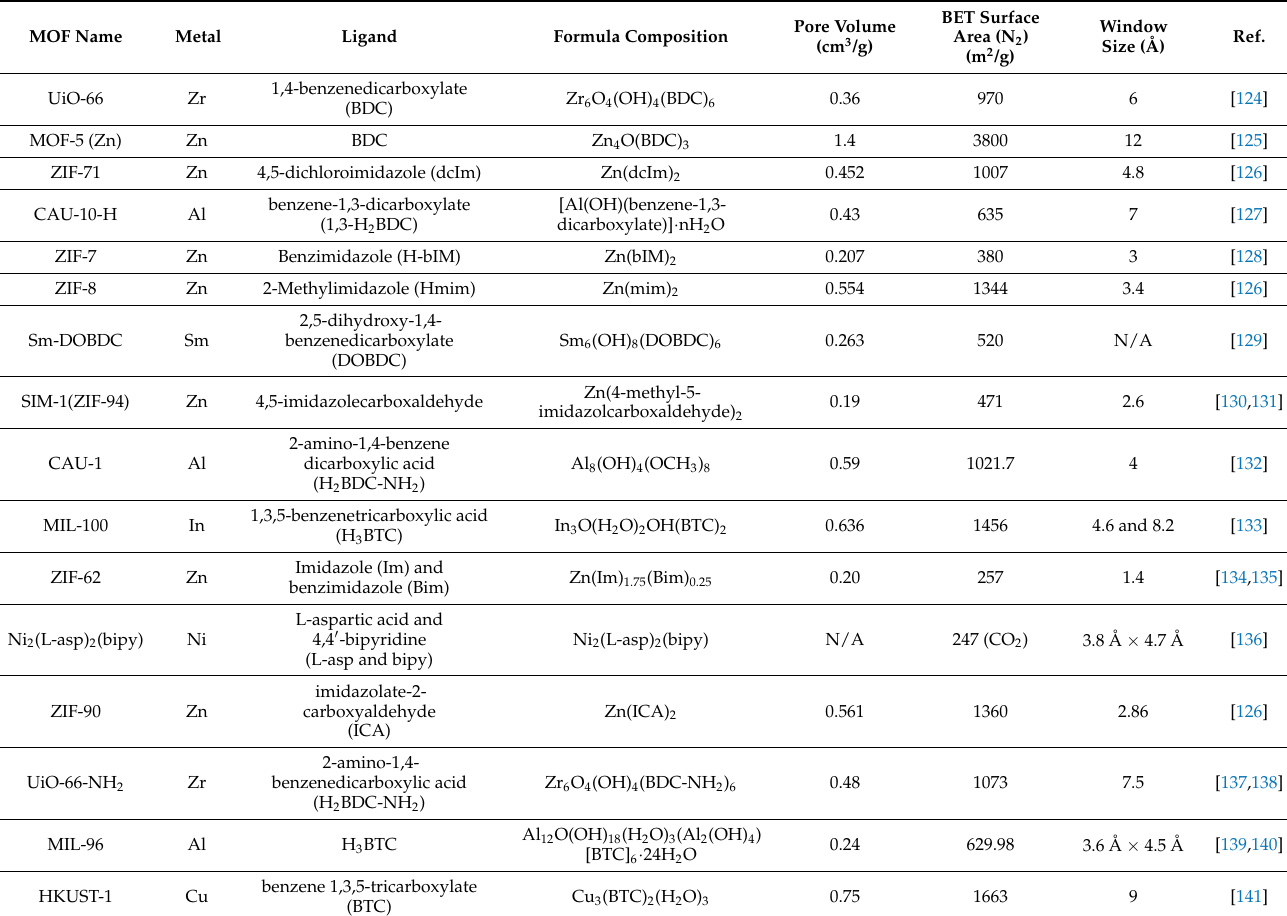
Table 1. Brief overview of structural parameters of MOFs utilized in gas separation and